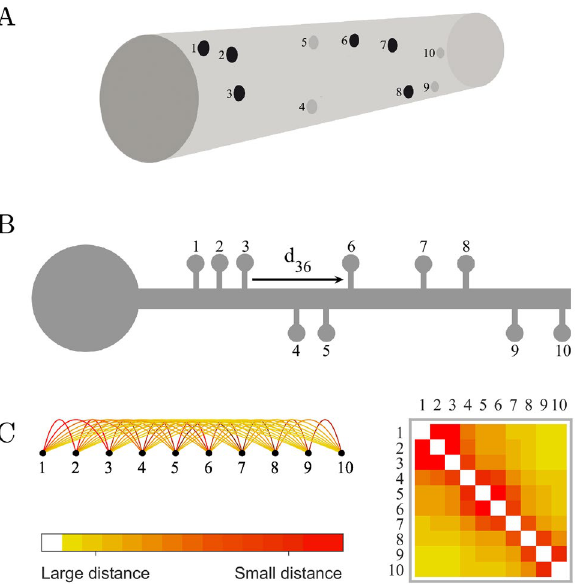
Figure 2. Dendrites as graphs. ( A ) 3D Visual representation of the spines (1 to 10) along a dendritic segment. ( B ) Calculation of the connection strength between pairs of spines, which is proportional to their physical closeness and can be measured as the inverse distance between the spines along the dendrite (e.g., d 36 is the distance between spines 3 and 6, and the respective connection strength is 1/d 36 ). ( C ) The resulting graph can be represented as an adjacency matrix, where each element in the matrix represents the strength of the connection between the nodes in the corresponding row and